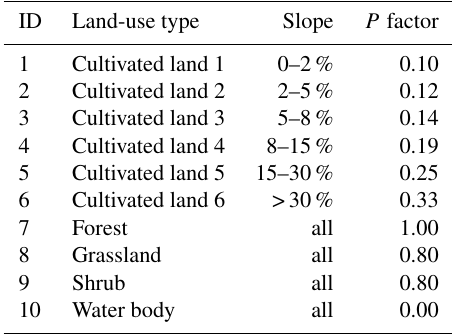
Table 2. Resulting P values using records of supporting Practices and land uses, 6 categories of agricultural lands based on